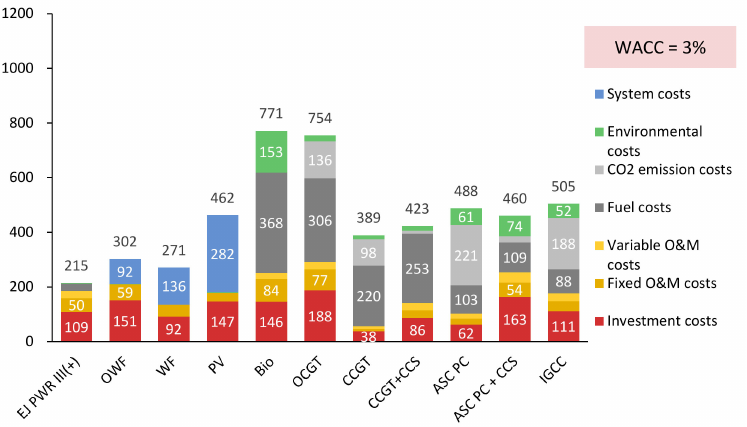
Figure 2. The low cost of capital makes nuclear power plants the cheapest source of electricity. Decom- position of the total levelised cost of electricity (T-LCOE). WACC = 3%; power generation technologies commissioned in 2035; 30% penetration of the given variable RES technology in the system.